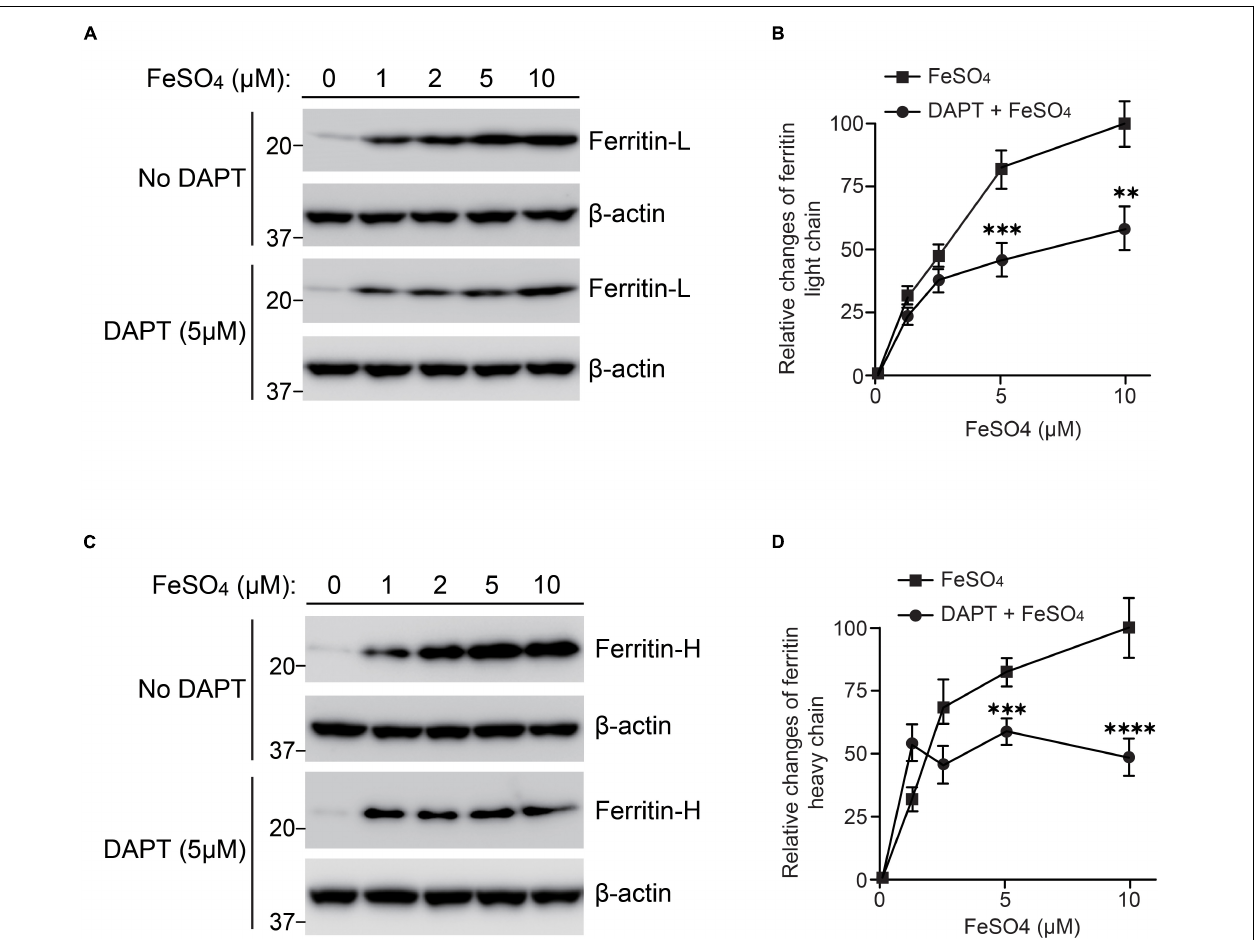
FIGURE 4 | Inhibition of γ -secretase activity reduced ferritin levels in response to iron treatment in wild-type fibroblasts. Wild-type fibroblasts were treated with or without 5 µ M DAPT in DMEM containing 10% FBS after seeding. After 1 h, ferrous sulfate was added and the cells were incubated at 37 ◦ C in 5% CO 2 for 72 h. (A) Western blot analysis of ferritin light chain in wild-type fibroblasts treated with or without ferrous sulfate or DAPT. (B) Quantification of intracellular ferritin light chain levels. Ferritin light chain levels at 10 µ M ferrous sulfate treatment (without DAPT) were normalized to α -tubulin protein levels and adjusted to 100%. The relative change of ferritin light chain at each concentration was calculated. DAPT treatment significantly inhibited intracellular ferritin light chain levels. n = 3, from 3 independent experiments, ∗∗ P < 0.01, ∗∗∗ P < 0.001, one-way ANOVA followed by Tukey’s multiple-comparison tests. (C) Western blot analysis of ferritin heavy chain in wild-type fibroblasts treated with or without ferrous sulfate or DAPT. (D) Quantification of intracellular ferritin heavy chain levels. Ferritin heavy chain levels in wild-type fibroblasts with 10 µ M ferrous sulfate treatment (without DAPT) were normalized to α -tubulin protein levels and adjusted to 100%. The relative change of ferritin light chain at each concentration was calculated. DAPT treatment significantly inhibited intracellular ferritin heavy chain levels. n = 3, from 3 independent experiments, ∗∗∗ P < 0.001, ∗∗∗∗ P < 0.0001, one-way ANOVA followed by Tukey’s multiple-comparison tests. (cid:4) , ferrous sulfate